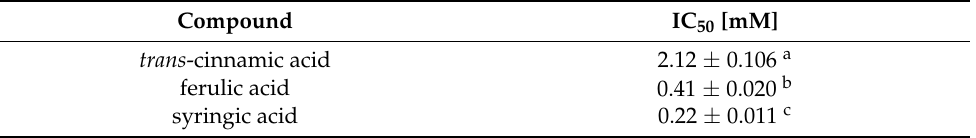
Figure 4. Molecular interactions of inhibitors with 5-lipoxygenase (5-LOX). ( A ) trans -cinnamic acid bound to an allosteric binding pocket (general view). The protein is shown in dark blue cartoon representation, trans -cinnamic acid in yellow ball representation and iron ion in magenta ball representation. ( B ) trans -cinnamic acid, ( C ) syringic acid and ( D ) ferulic acid in a binding pocket of 5-LOX. The protein is shown with cyan carbon atoms in wire representation with the most important residues shown as sticks. Inhibitors are depicted with gray carbon atoms in stick representation. Polar bonds are shown as red dashes. Nonpolar hydrogen atoms omitted for clarity. Table 3. ABTS radical scavenging ability of chosen phenolic compounds, n =